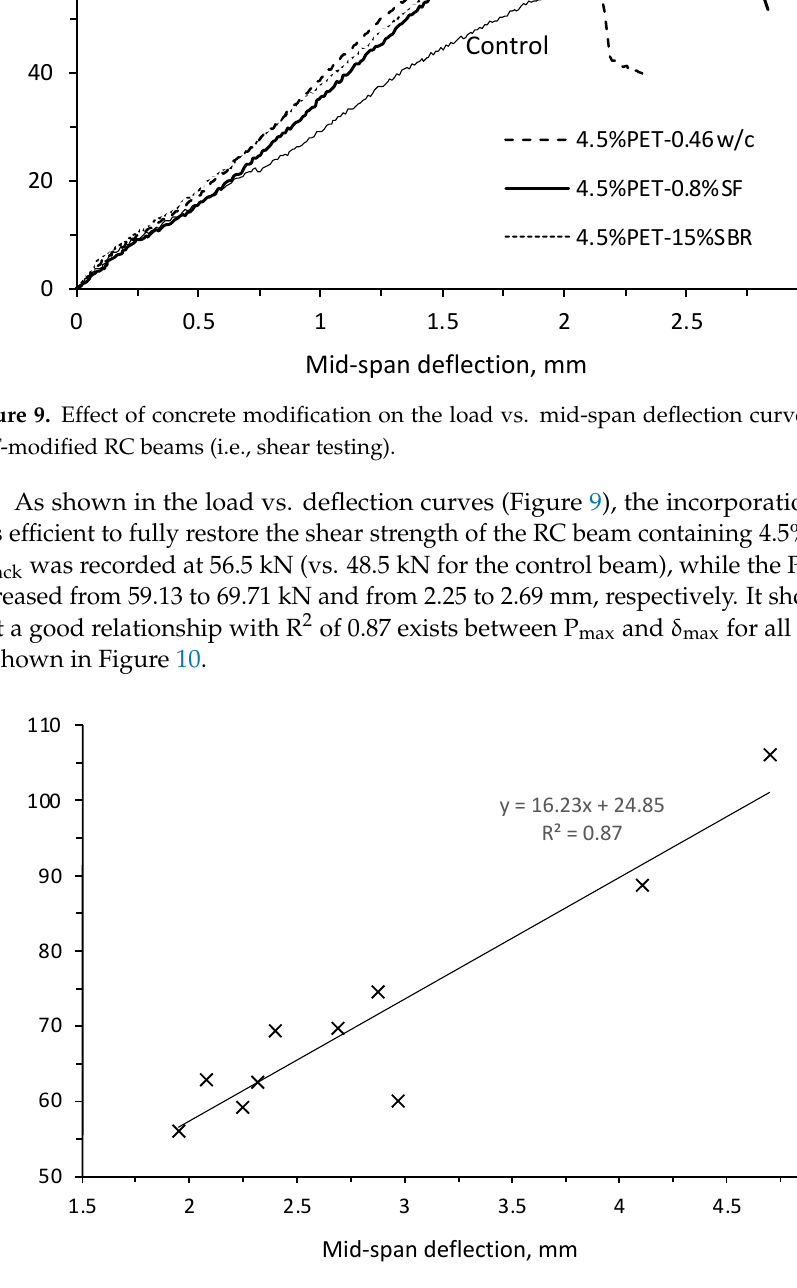
12 of 17 Figure 8. Effect of concrete modification on P max and δ max for RC beams without stirrups. 4.3.3. Effect of Concrete Modification Reduced w/c — Despite the relatively high PET rate of 4.5%, the effect of reducing w/c from 0.55 to 0.46 seems efficient to increase the stiffness in the pre-peak region of the load vs. deflection curves, and fully reinstate the shear resistance of the RC beams (Figure 9). Hence, V crack remarkably increased from 48.5 to 57 kN for the control and 4.5%PET-0.46w/c beams, respectively, which can be attributed to the increased concrete strength (such as f′ c